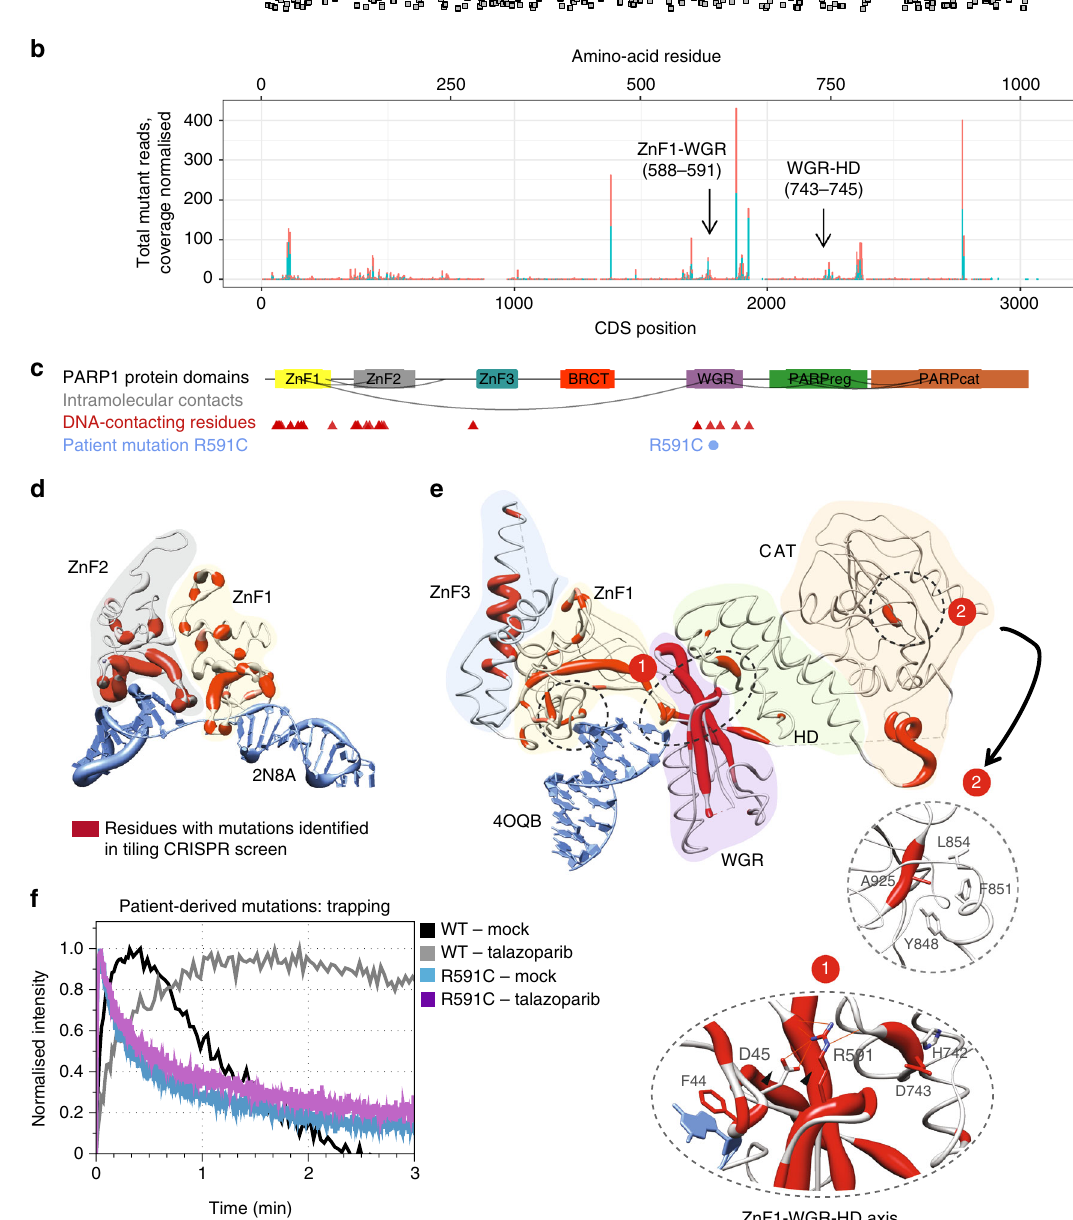
Fig. 4 A high-density tiling CRISPR-Cas9 screen enables functional annotation of a PARP1 mutation observed in an olaparib-resistant patient. a Positions of sgRNA target sites in the dense PARP1 tiling library mapped onto the PARP1 coding DNA sequence shown in b . b Positions of mutations identi fi ed in the dense PARP1 tiling screen. Number of mutant reads for in-frame mutant alleles affecting each base is shown on the y -axis normalised to per-base coverage (mutant reads/total coverage × 1000). Only sites with coverage >500 reads are shown. The experiment was repeated in duplicate from two independently tagged SUM149 PARP1-GFP cell lines (clone 5 and 8, shown in red and blue). Arrows highlight the mutations observed at inter-domain contacts as shown in e . c Positions of protein domains mapped onto the PARP1 protein sequence. Red triangles indicate DNA – protein contacts based on crystal structures, blue circles show the location of the patient mutation identi fi ed in this study. Grey arcs represent key inter-domain contacts as shown in e and Fig. 2g. d Ribbon plot of ZnF1 and ZnF2 bound to a single-strand break (PDB: 2N8A). Ribbons are coloured red by residue based on the frequency of mutations observed in the tiling screen affecting that residue as shown in b . The thickness of the ribbon is proportional to the frequency of mutations observed affecting that residue. e Ribbon plot of the PARP1-DSB crystal structure (PDB: 4OQB) highlighting the clustering of mutations along the hydrogen-bonding axis postulated in Fig. 2g and the A925 residue that abuts Y848 (inset 2). Regions marked 1 and 2 are magni fi ed. f Analysis of trapping for the R591C patient mutation by microirradiation with or without talazoparib as shown. Although the R591C mutant can bind DNA at sites of damage (blue line), it is not trapped in the presence of talazoparib (purple